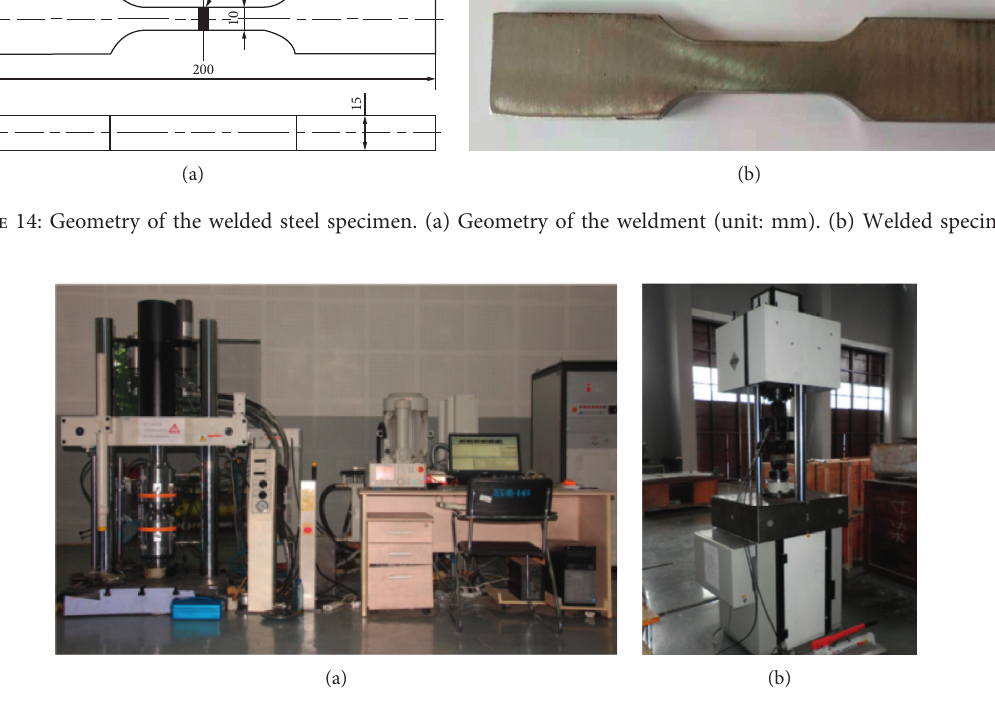
Figure 15: Electrohydraulic servo high-frequency fatigue testing machine